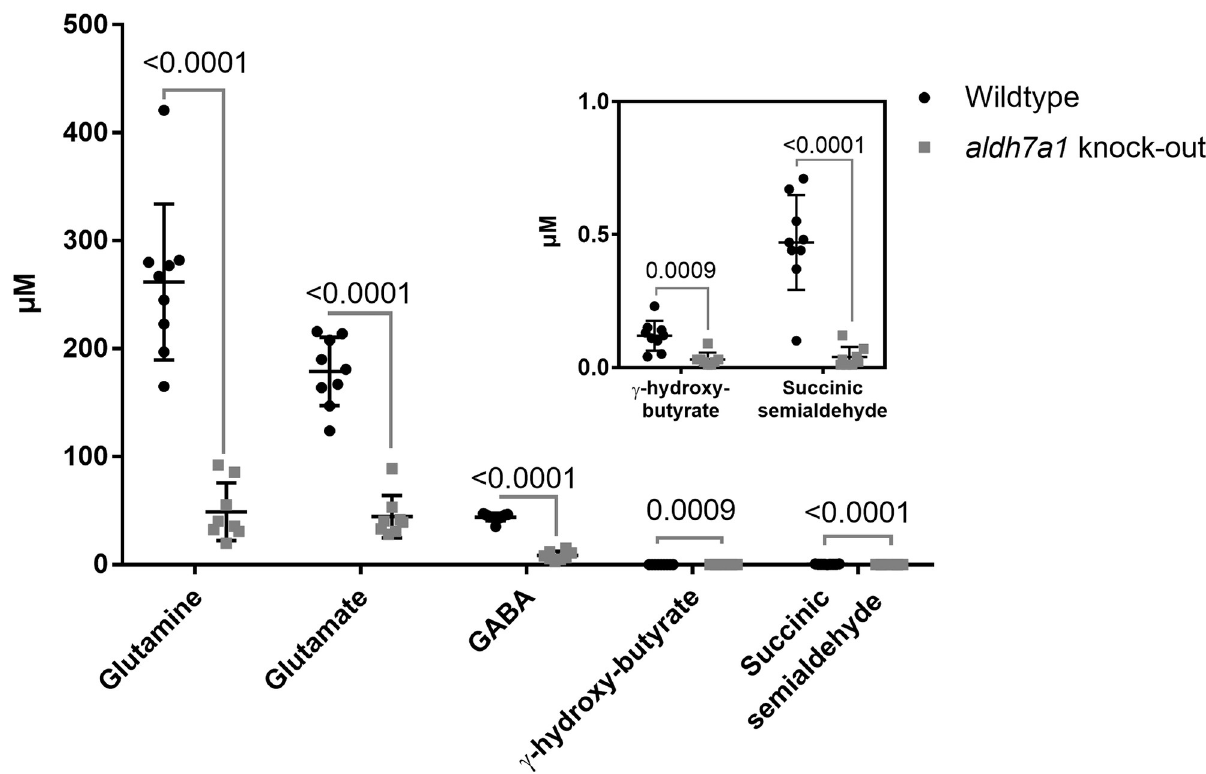
Fig 3. Scatterplot of quantification of the levels of GABA metabolism pathway metabolites. The levels of GABA metabolism reaction intermediates are reduced in aldh7a1 knock-out zebrafish embryos. It is shown in a scatterplot of quantification of the levels of GABA metabolism pathway metabolites, as measured by GC-MS and LC-MS/MS. The metabolite levels in 11 dpf aldh7a1 homozygous knock-out (aldh7a1 knock-out, grey squares) embryos are significantly decreased relative to the wildtype (Wildtype, black circles). Each dot represents metabolite data collected from 20 embryos. p values were calculated by unpaired student t-test for multiple measurements followed by Holm-Sadak correction for multiple analysis. Error bars, SD.